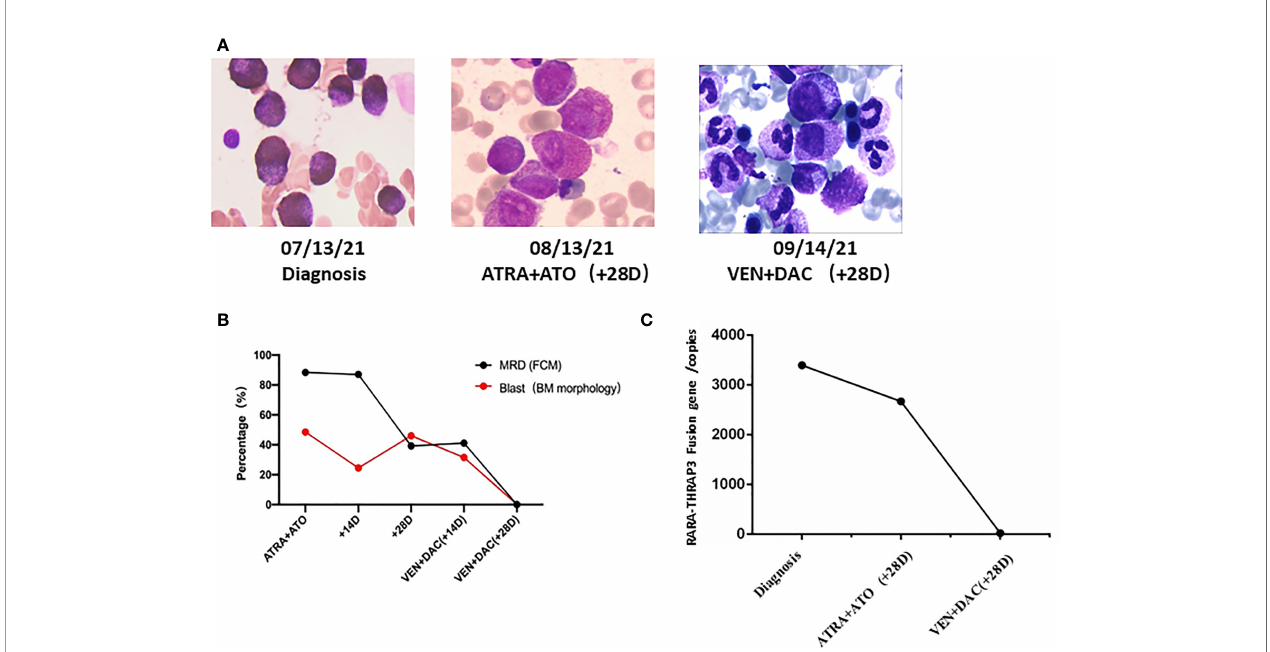
FIGURE 2 | The novel recurrent RARA-THRAP3 fusion APL patient was salvaged by low-dose venetoclax combined decitabine. (A) Timeline of treatment and bone marrow blast percentages for patient (×1,000). (B) Flow cytometric immunophenotyping of primary diagnosis. (C) RARA-THRAP3 fusion gene was detected by RT- PCR. BM, bone marrow; FCM, fl ow cytometry; MRD, minimal residual disease; DAC, decitabine; VEN,